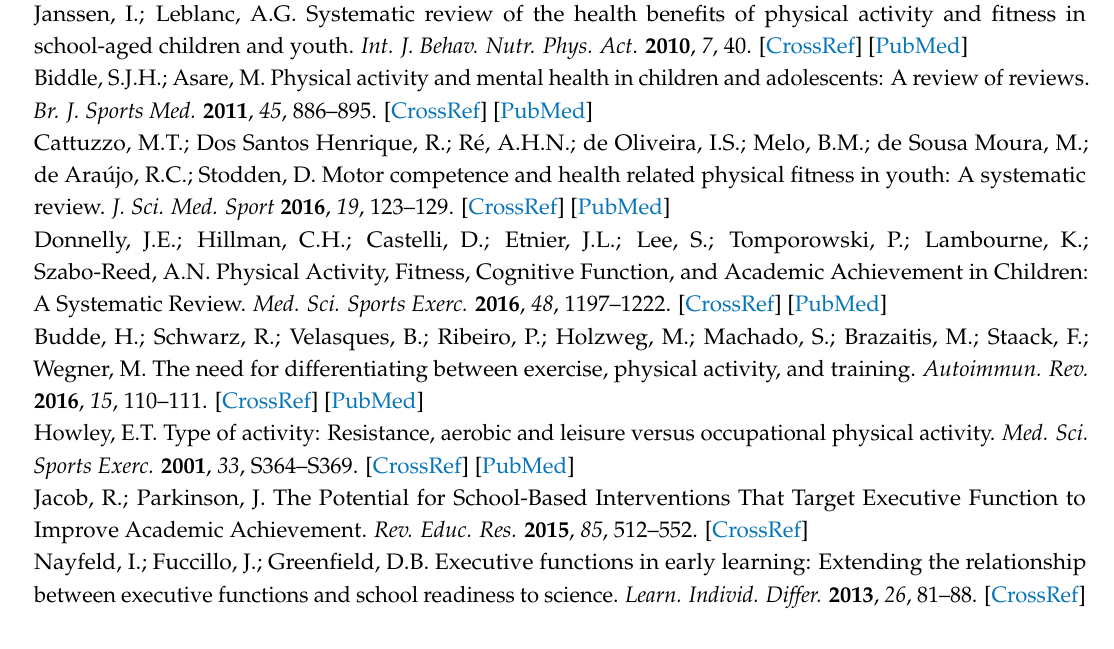
Table S1: Example sessions for the aerobic training, Table S2: Example sessions for the coordinative training, Table S3: Results of the examination of gender-specific effects on the change in neurocognitive (P300 amplitude and latency) and behavioral measures of cognitive performance (reaction time and